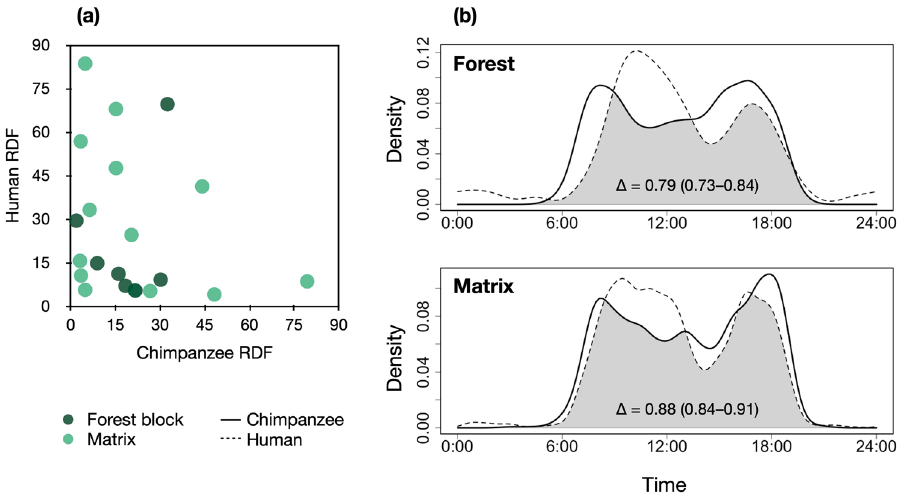
Figure 2. Comparison of relative detection frequency (RDF) ( a ) and temporal activity patterns ( b ) between chimpanzees and humans during a 12-month period across 21 camera trap sampling sites in Caiquene– Cadique. ∆ is the coefficient of overlap 68,69 . Values in brackets represent 95% confidence